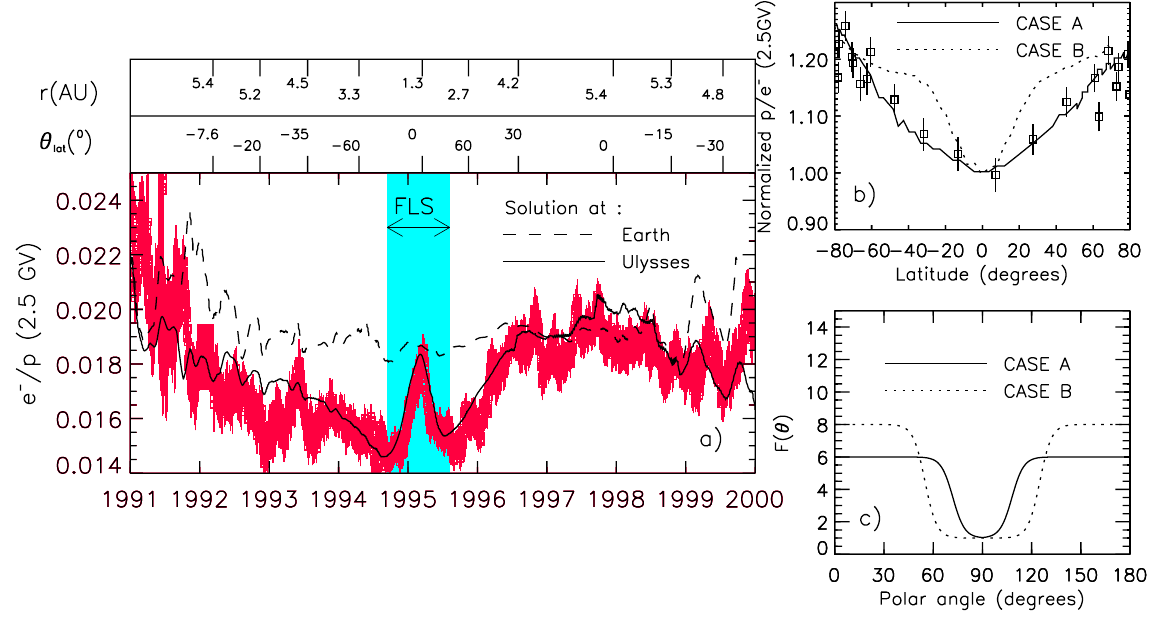
Fig. 4. (a) Computed 2.5GV electron to proton ratio (e/p) along Ulysses’ trajectory (solid line) and at Earth (dotted line) in comparison with the 2.5GV e/p observations from KET (Heber et al., 1996; 1999; 2002). (b) Two computed proton-to-electron ratios (p/e) as a function of Ulysses’ latitude for the fast latitude scan period around 1995 in comparison with the observed p/e from KET. CASE A and CASE B correspond to two assumptions of K ⊥ θ in Eq. (3) by changing F(θ) as a function of polar angle shown in (c) ; CASE B, dotted line, corresponds to d = 8 and θ F = 35 ◦ and CASE A, solid line, to d = 6 and θ F = 15 ◦ in Eq.